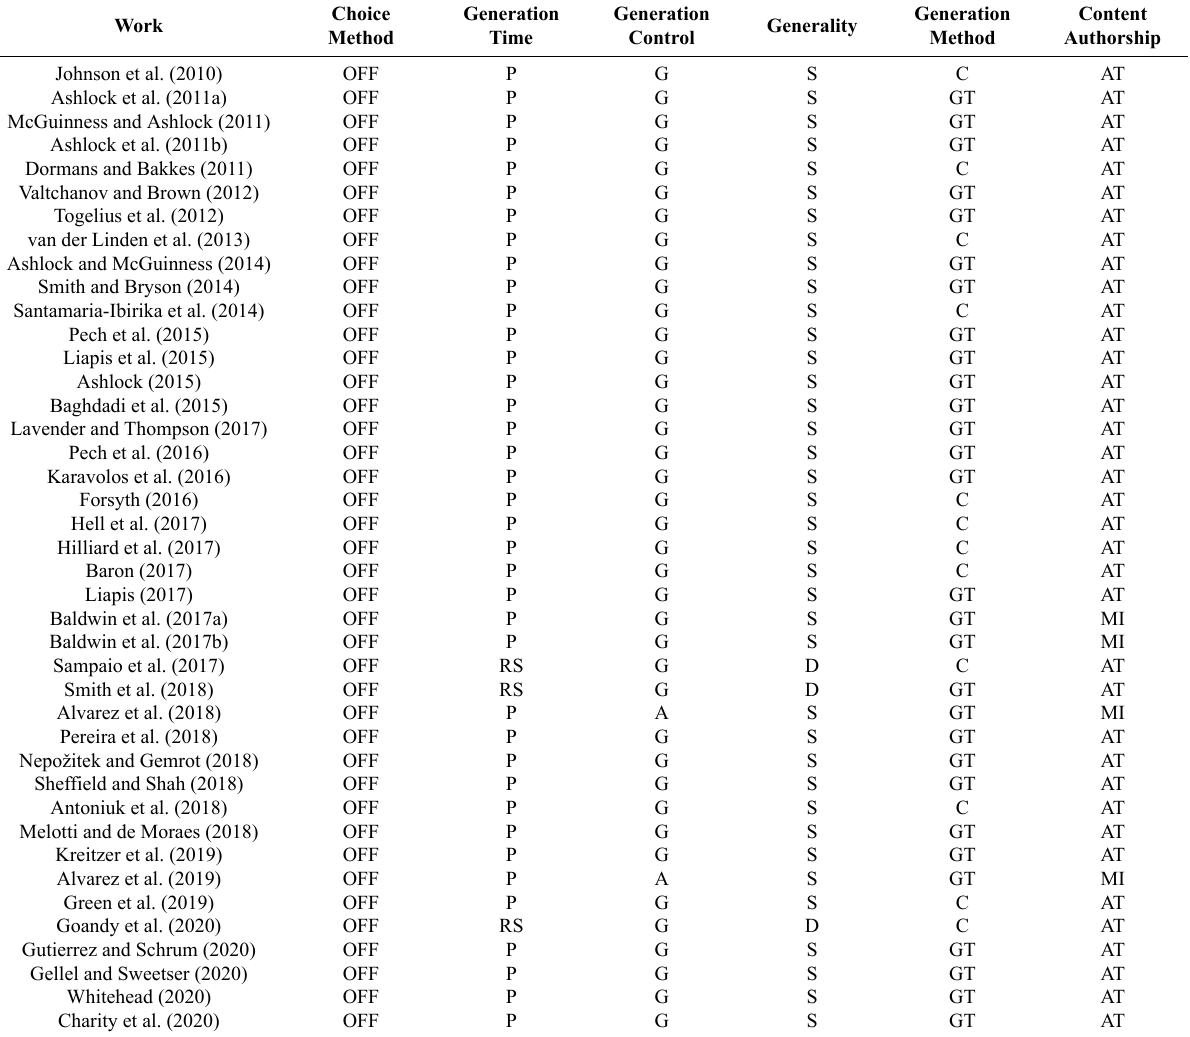
Table 3. PCG taxonomy data collected from the found papers. Classifications: ON (online); OFF (offline); P (parameters); RS (random seeds); G (generic); A (adaptive); S (stochastic); D (deterministic); C (constructive); GT (generate­and­test); AT (automatic), and; MI